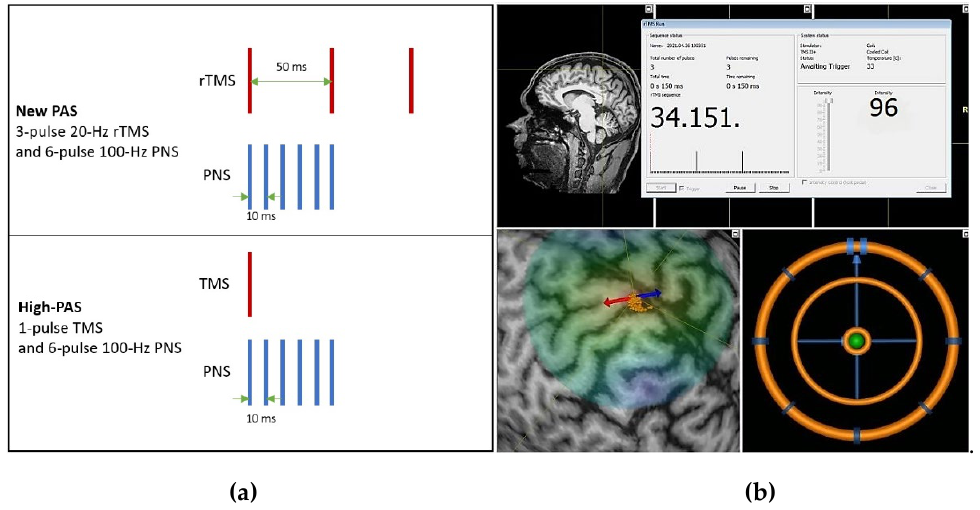
Figure 1. (a) Schematic representation of the new 3-pulse PAS and the high-PAS; (b) The nTMS Figure 1. ( a ) Schematic representation of the new 3-pulse PAS and the high-PAS; ( b ) The nTMS interface showing the TMS pulse focused on the hotspot over M1. interface showing the TMS pulse focused on the hotspot over M1.